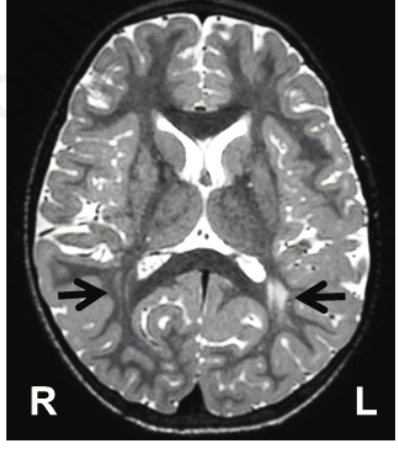
Figure 1. Magnetic resonance imaging demonstrates chronic deep white matter ischemia. Standard T2 weighted imaging was performed under sedation which showed abnormal T2 hyperintense signal (arrows) within the bilateral peritrigonal white matter (left greater than